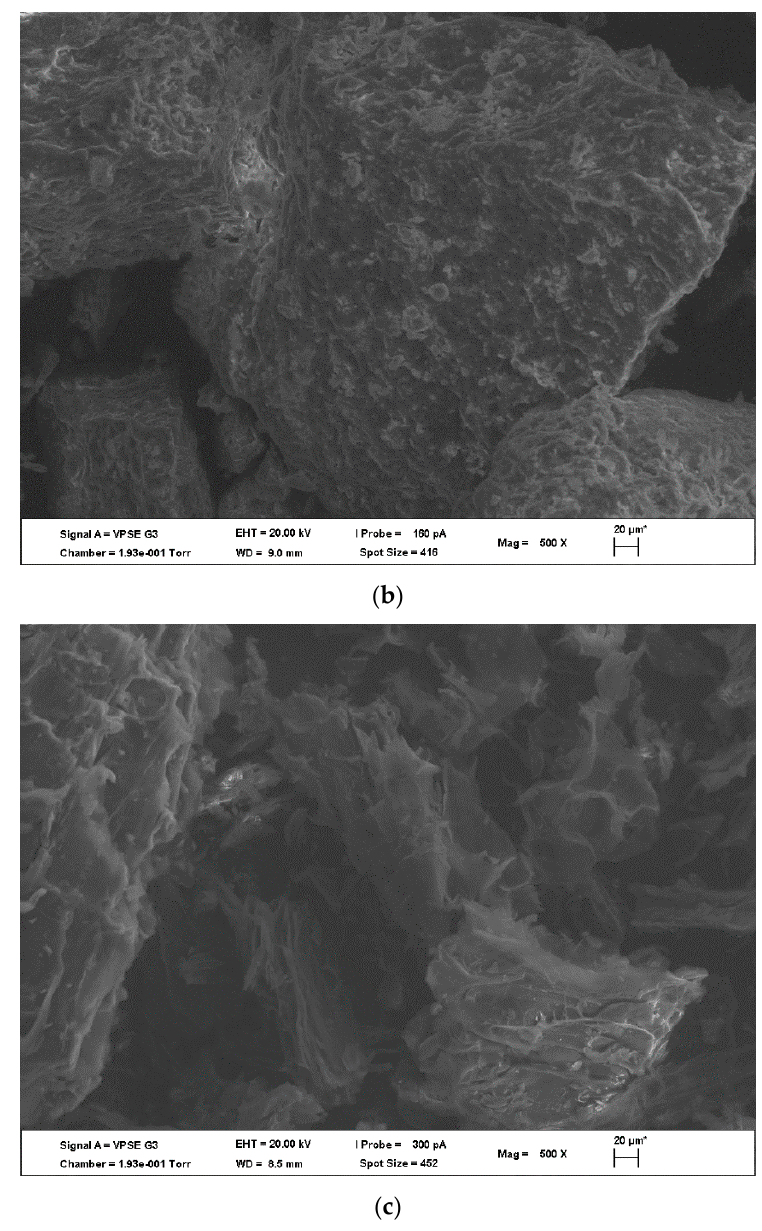
Figure 7. Morphological comparison of biochar types produced at 350 °C from ( a ) latrine waste, ( b ) sewage sludge and ( c ) pine bark.